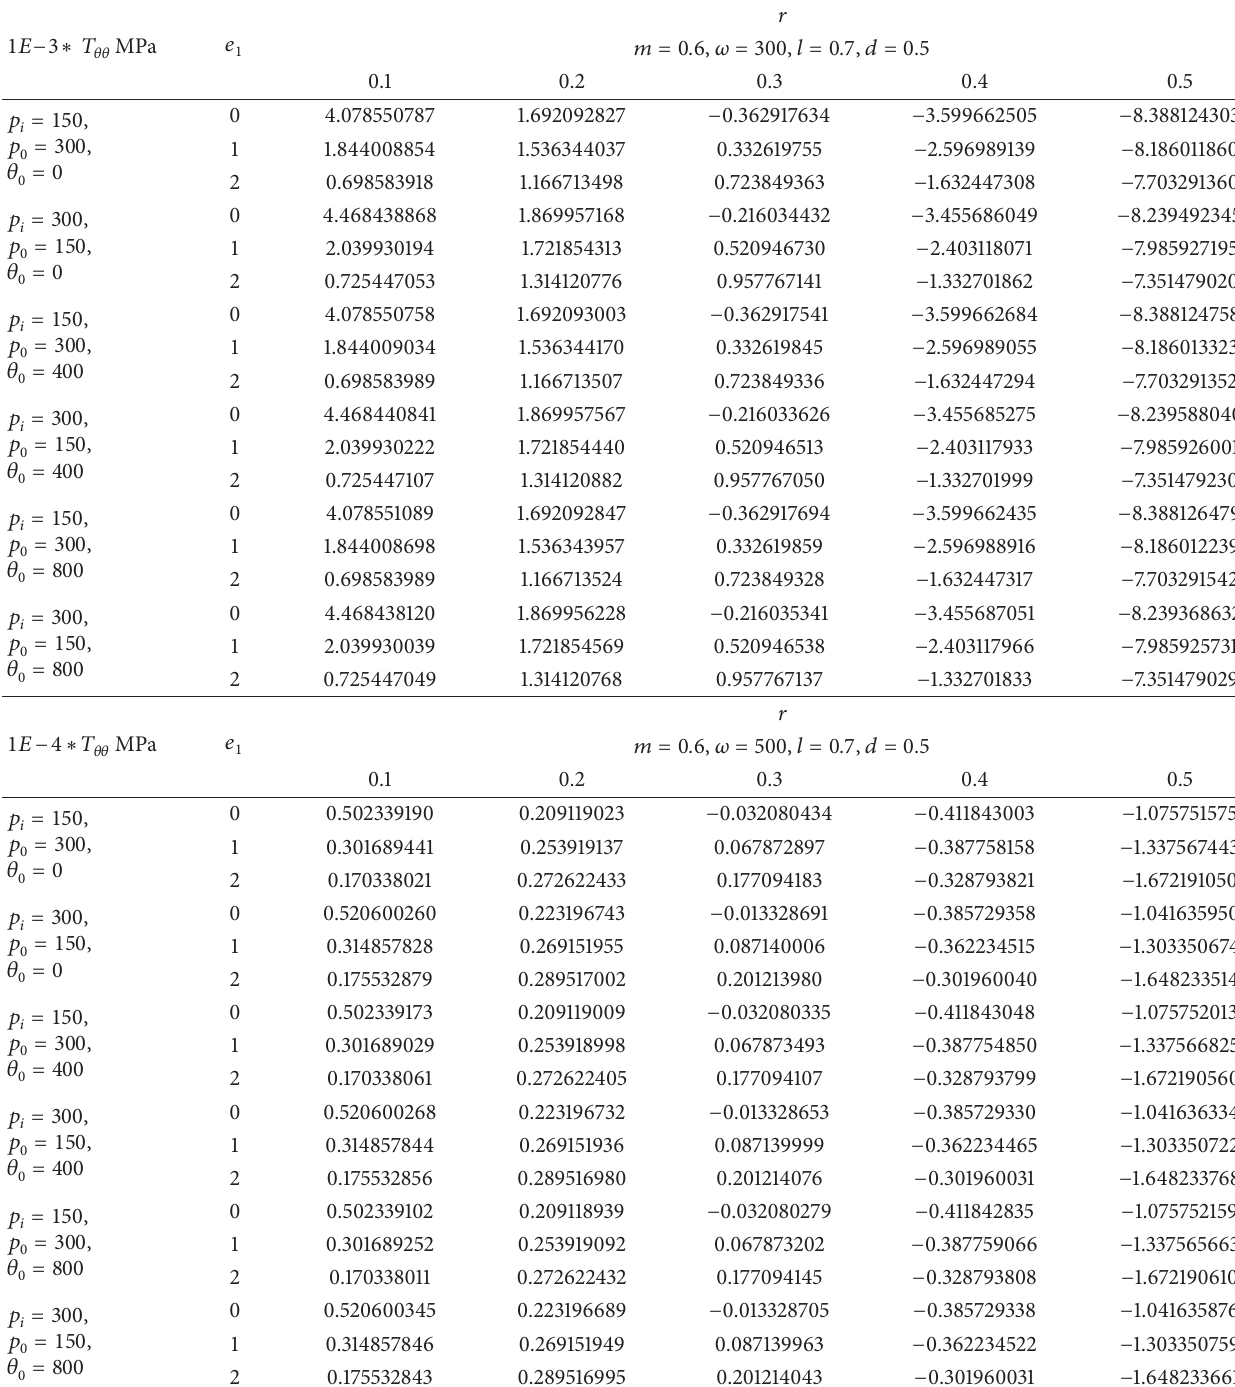
Table 4: Circumferential stresses for rotating cylinder with variable thickness and variable density 𝑙 = 0.7 , 𝑑 = 0.5 , 𝜔 = 300, 500 , strain hardening measure 𝑚 = 0.6 , and different parameters of Young’s modulus under internal and external